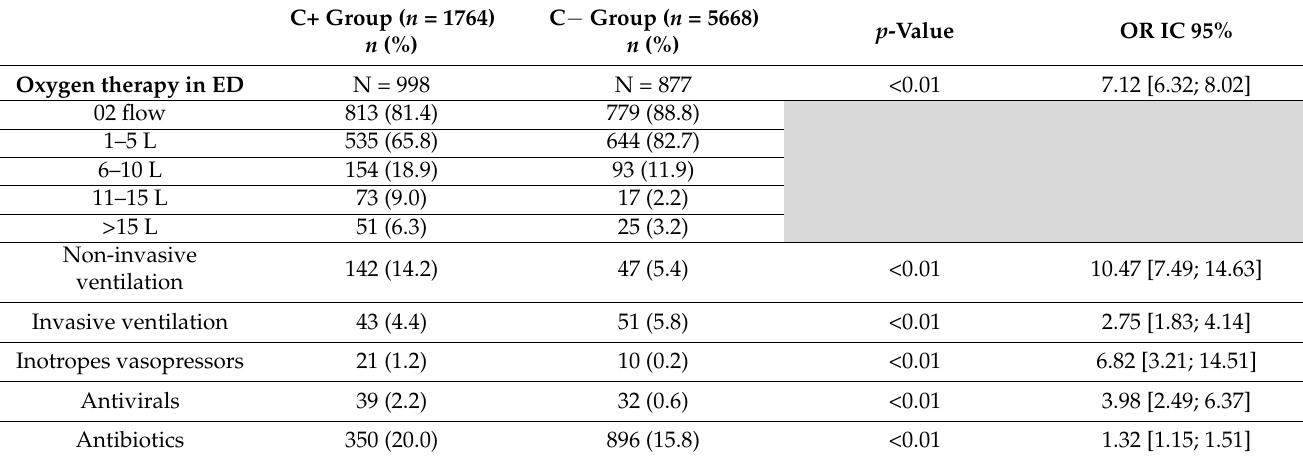
Table 6. Therapeutic strategy in emergency